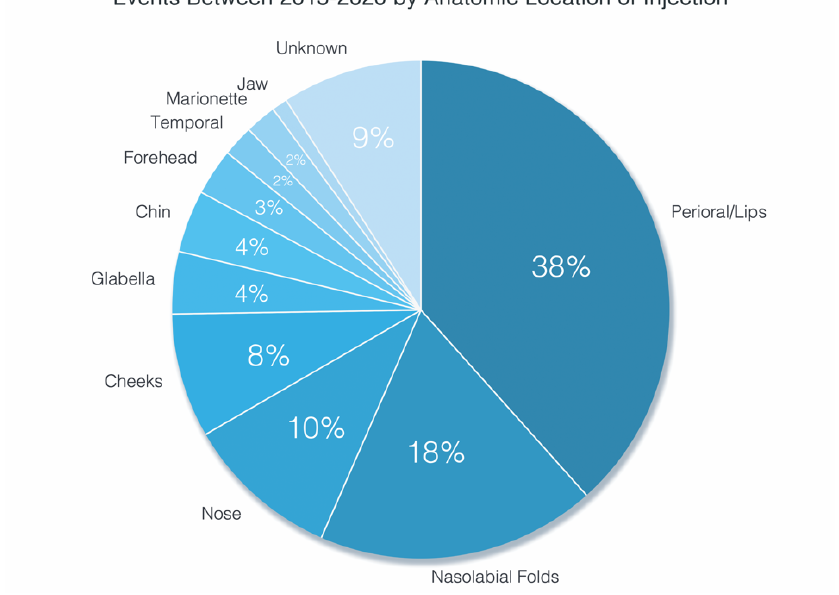
Figure 3. Food and Drug Administration (FDA) Medical Device Reports (MDRs) data for filler-associated vascular events reported between 2015 and 2020; data from [36].